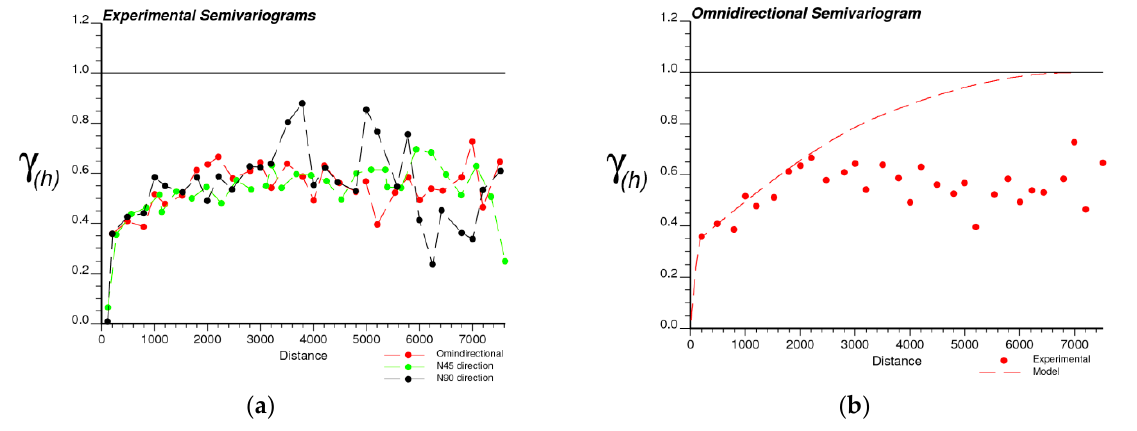
Figure 7. ( A ) Experimental variograms in the directions N45, N90, and omnidirectional and the ( B ) adjusted model for the omnidirectional variogram.